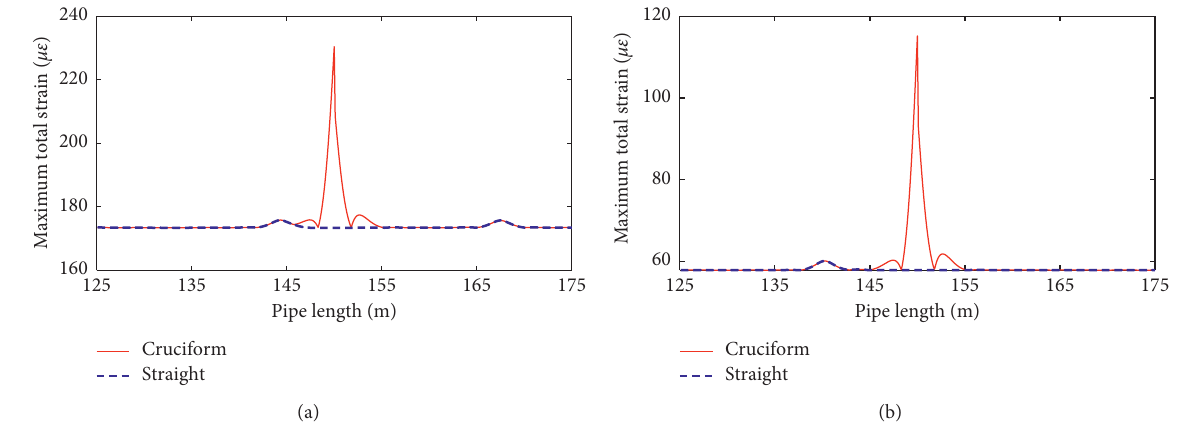
Figure 19: Maximum total strain with different incident angles: (a) 30 ° ; (b) 60 ° .